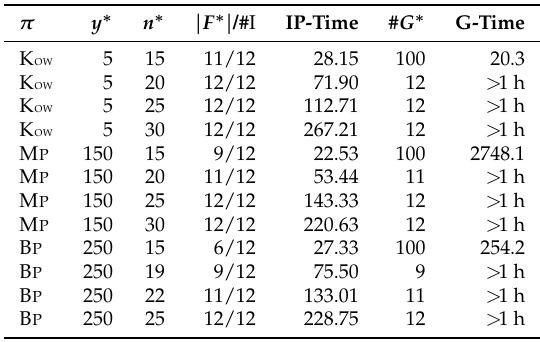
Table 8. Results of Steps 4 and 5 with d max = 4 and θ =